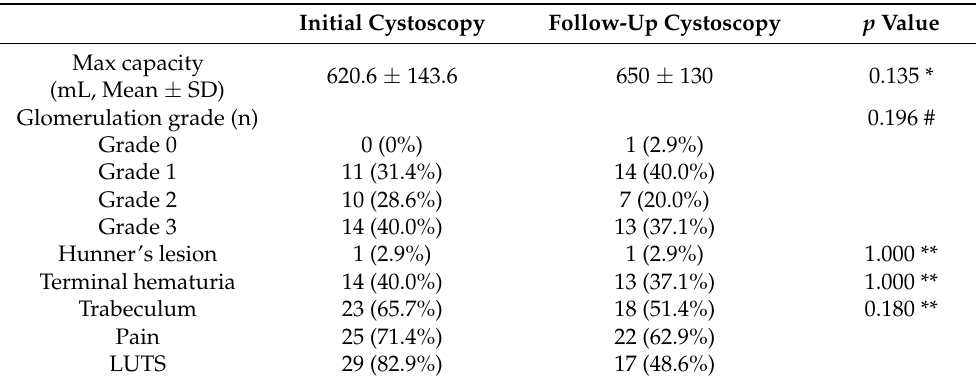
Table 2. The data of initial and follow-up cystoscopic findings of the patients (n = 35) who underwent intravesical hyaluronic acid